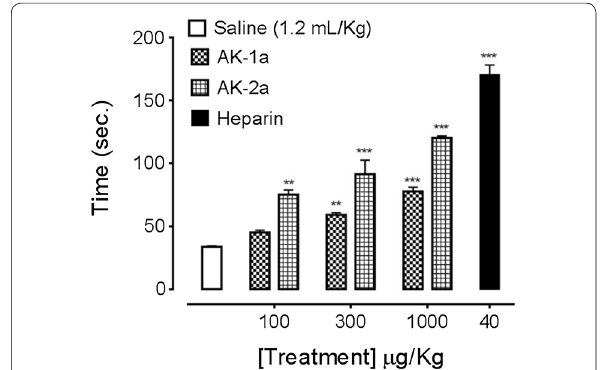
Fig. 17 Bar chart showing increase in tail bleeding time (BT) caused by different doses of (2 E ,5 E )‑2‑(4‑methoxybenzylidene)‑5‑(4‑nitro benzylidene) cyclopentanone (AK‑1a), (1 E ,4 E )‑4‑(4‑nitrobenzylid ene)‑1‑(4‑nitrophenyl) oct‑1‑en‑3‑one (AK‑2a) and heparin in mice. Data expressed as mean SEM, n 4, ** P < 0.01 and *** P < 0.001 vs. ± = saline group, one way ANOVA with post hoc Tukey’s